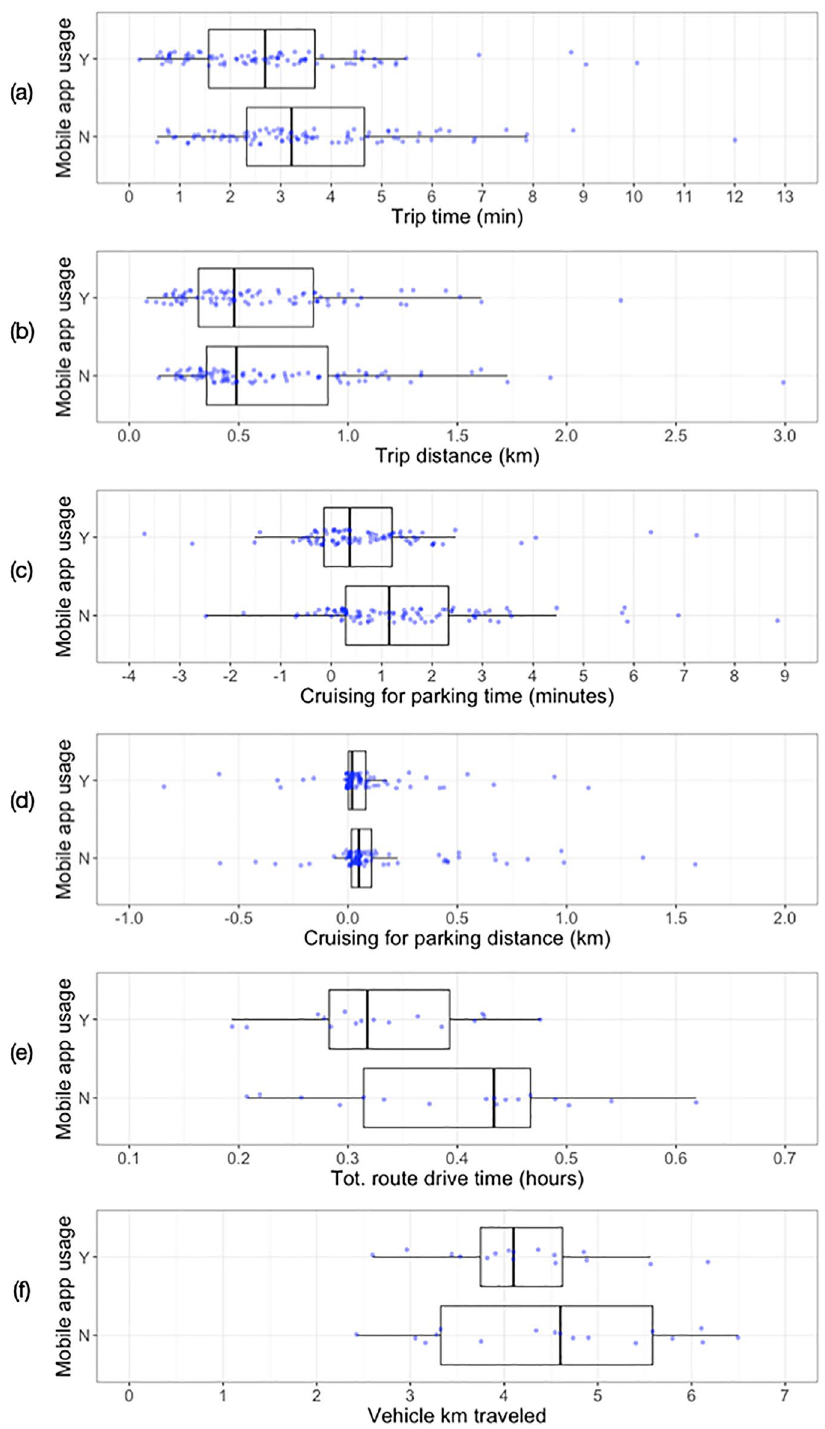
Figure 5. Empirical distributions of the variables of interest collected by performing routes with (mobile app usage = Y) and without (mobile app usage = N) the mobile parking information